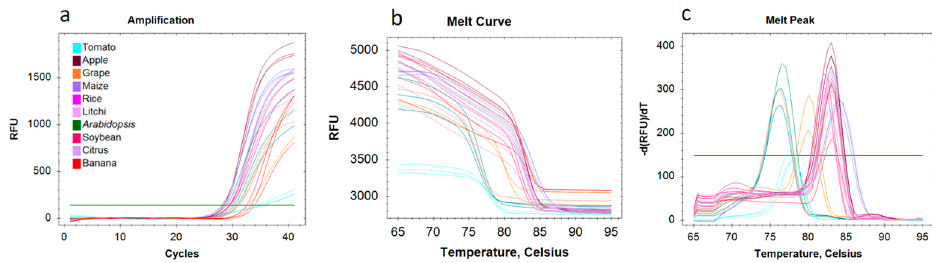
Figure 5. Nuclear RNA quality monitoring. ( a ) Actin amplification curve of the nuclei RNA of ten plants. ( b ) Melt curve of the nuclei of ten plants. ( c ) Melt peak of the nuclei of ten plants. Each color represents a different plant species.